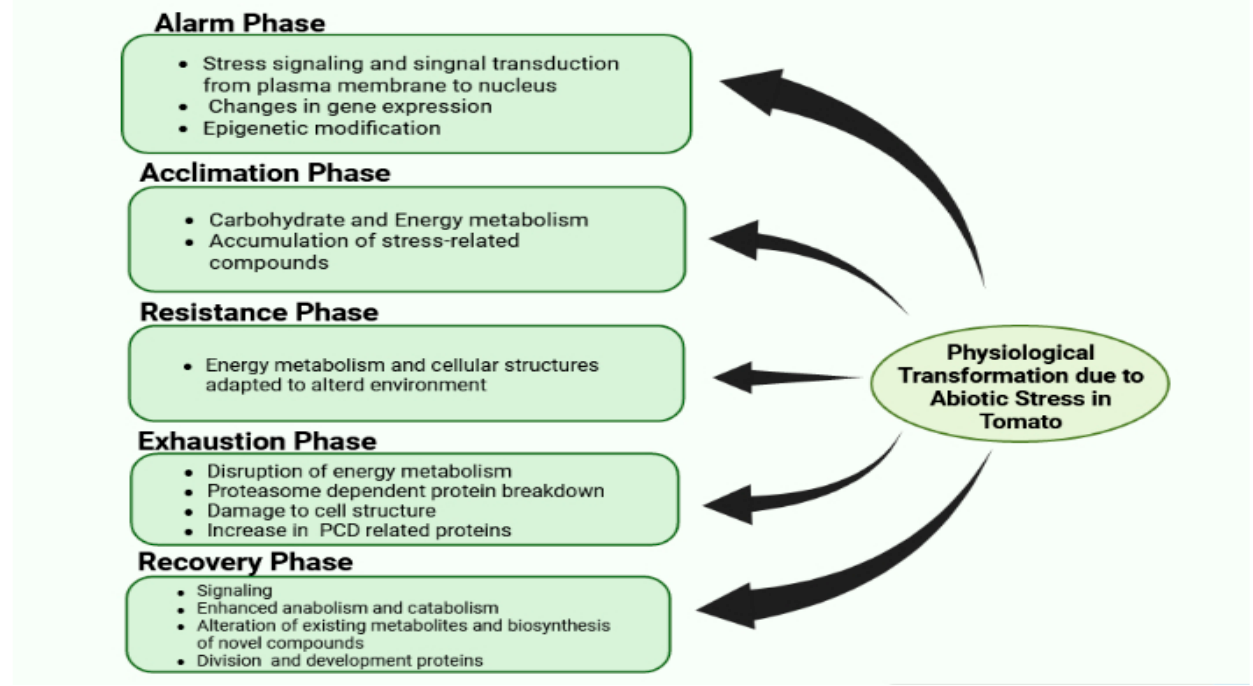
Figure 2. Physiological transformation due to abiotic stress in tomato.